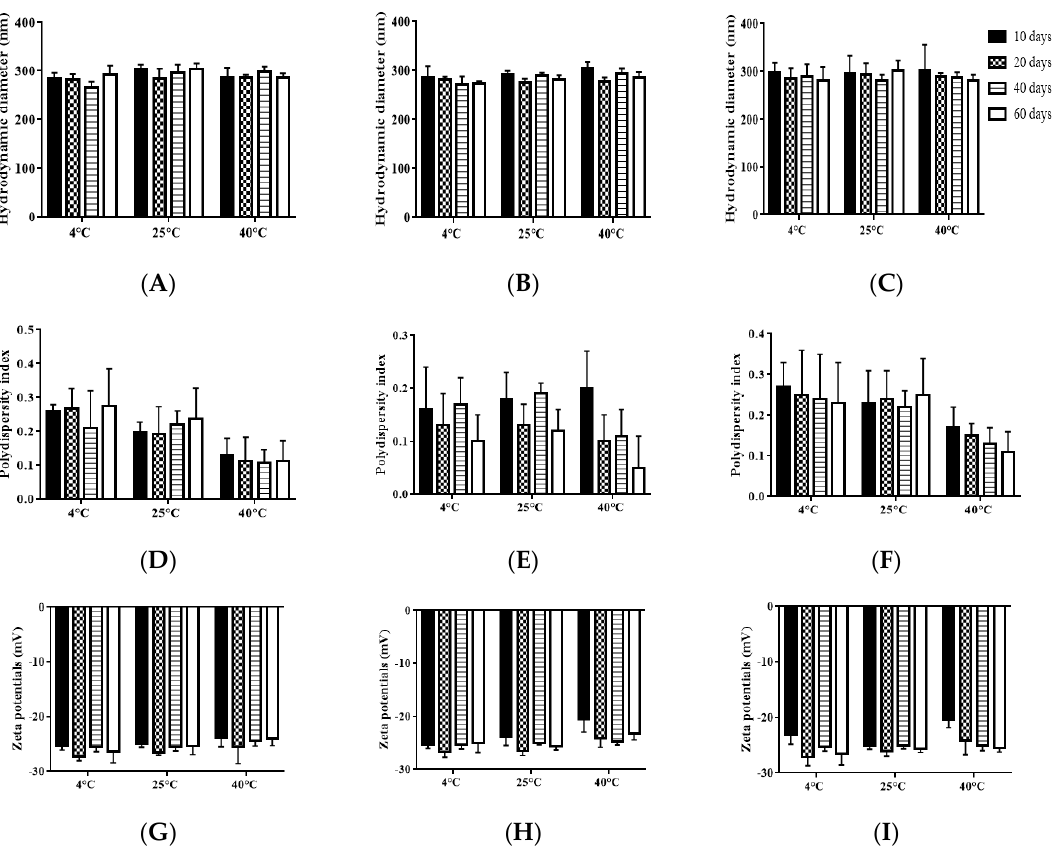
Figure 6. Storage stability of TMS ‐ NLCs after 60 days of storage at 4 °C, 25 °C, and 40 °C. ( A – C ) Hydrodynamic diameters of TMS ‐ pNLCs, TMS ‐ lNLCs, and TMS ‐ sNLCs, respectively. ( D – F ) The polydispersity index of TMS ‐ pNLCs, TMS ‐ lNLCs, and TMS ‐ sNLCs. ( G – I ) The exhibited zeta potentials of TMS ‐ pNLCs, TMS ‐ lNLCs, and TMS ‐ sNLCs, respectively. All the values are presented as means ± SD ( n = 3).